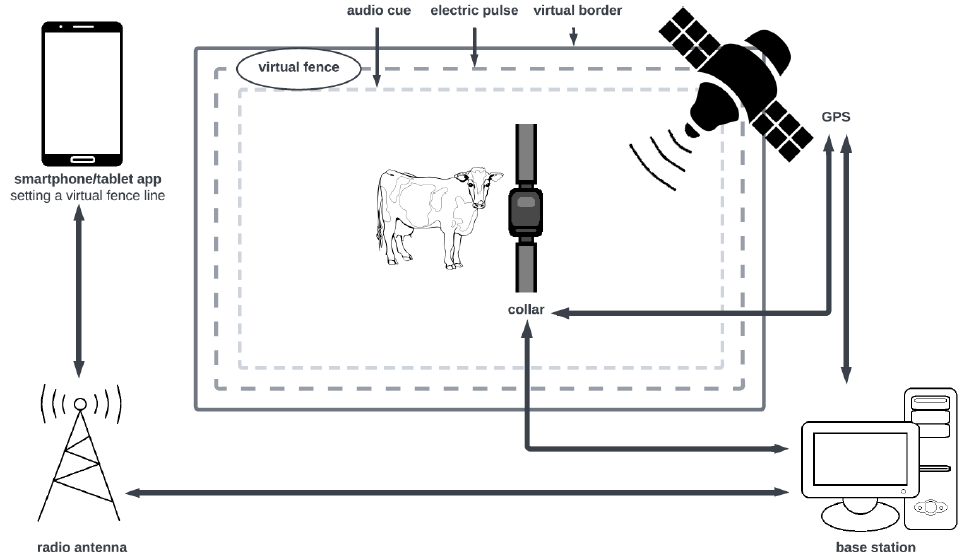
Figure 1. General concept of virtual fencing for grazing